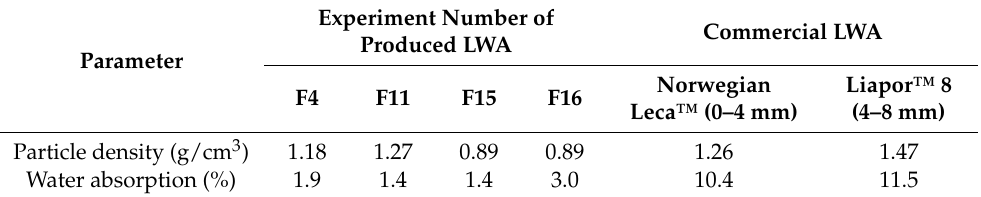
Table 15. Process parameters and design levels.